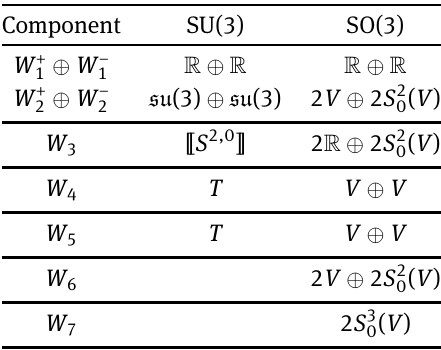
Table 2.1: SU(3) and SO(3) -intrinsic torsion. To compare with [13], observe that W 1 ⊕ W 3 ⊕ W 4 ∼ = B 3 ⊕ A 2 B 1 ⊕ A 4 B 1